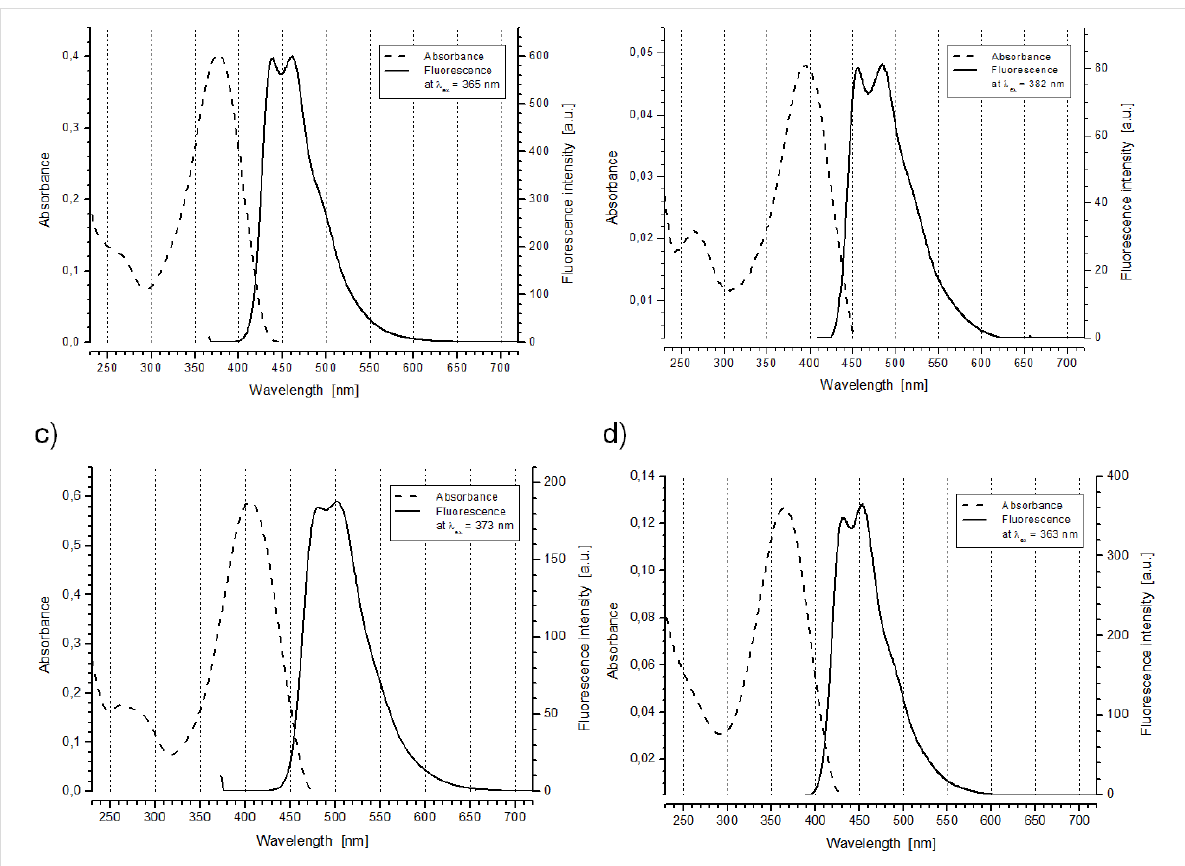
Figure 1: UV–vis absorption and fluorescence spectra of diluted solutions of a) 13 , b) 14 , c) 15 , and d) 18 in dichloromethane. Optimum fluorescence excitation wavelengths (given in the legends) have been selected based on fluorescence emission profiles.